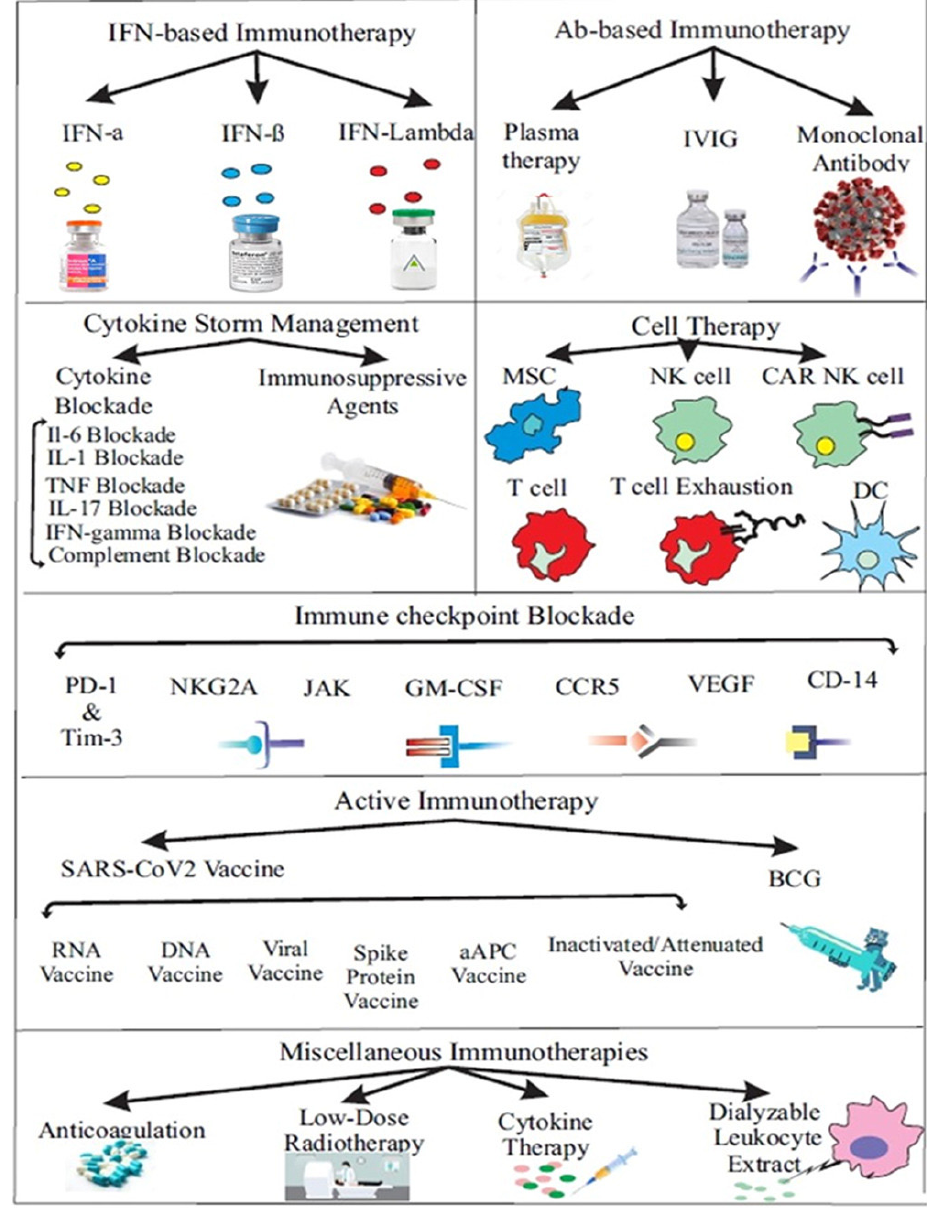
Figure 4. Development of therapeutics targeting immune responses for COVID-19 through interferon- and antibody-based therapies, cytokine storm management, anti-inflammatory radiotherapy, and cell therapy [61].